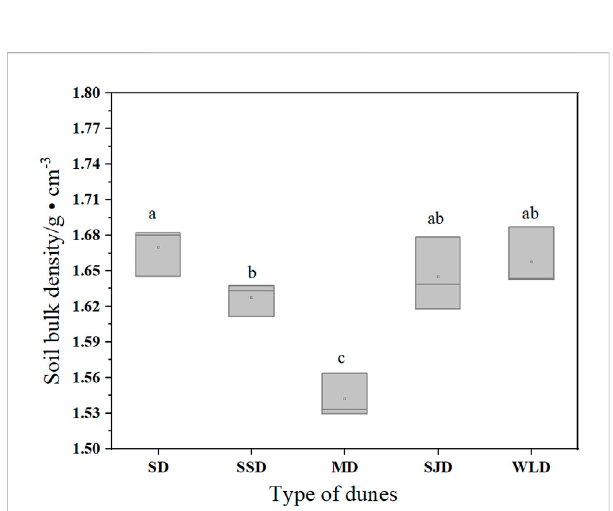
FIGURE 3 Soil bulk density 80 cm below the surface of deposits in dunes examined in the WPSER. Note: different letters indicate soil bulk density differed signi fi cantly between communities ( p < 0.05); the same letter indicates no signi fi cant difference ( p > 0.05).